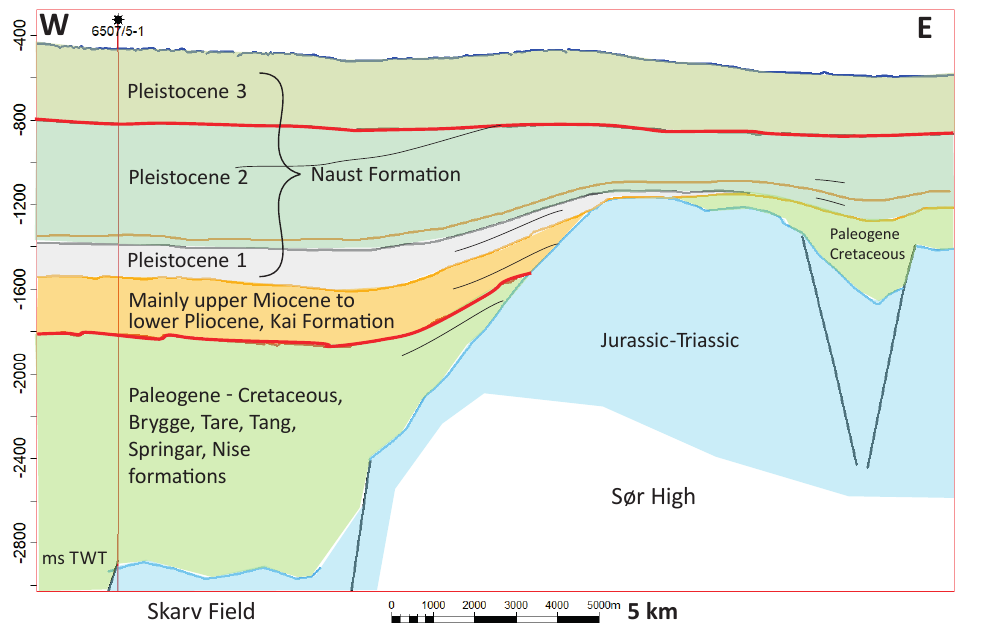
Figure 17. Geoseismic E–W section through the Skarv Field and Nordland Ridge (Sør High). Unconformities marked by red lines. Pleistocene 1 was previously interpreted to be upper Miocene–lower Pliocene Kai Formation (modified after Riis et al., 2019; Riis & Wolff,